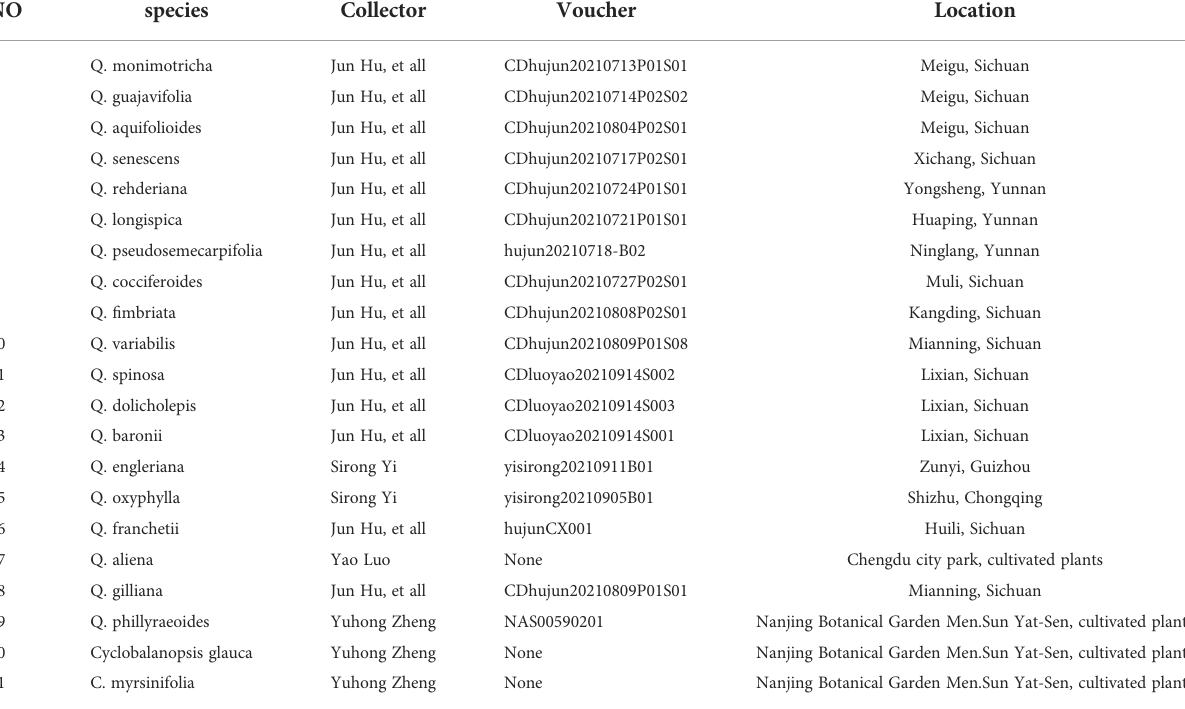
TABLE 1 Leaves for electrochemical